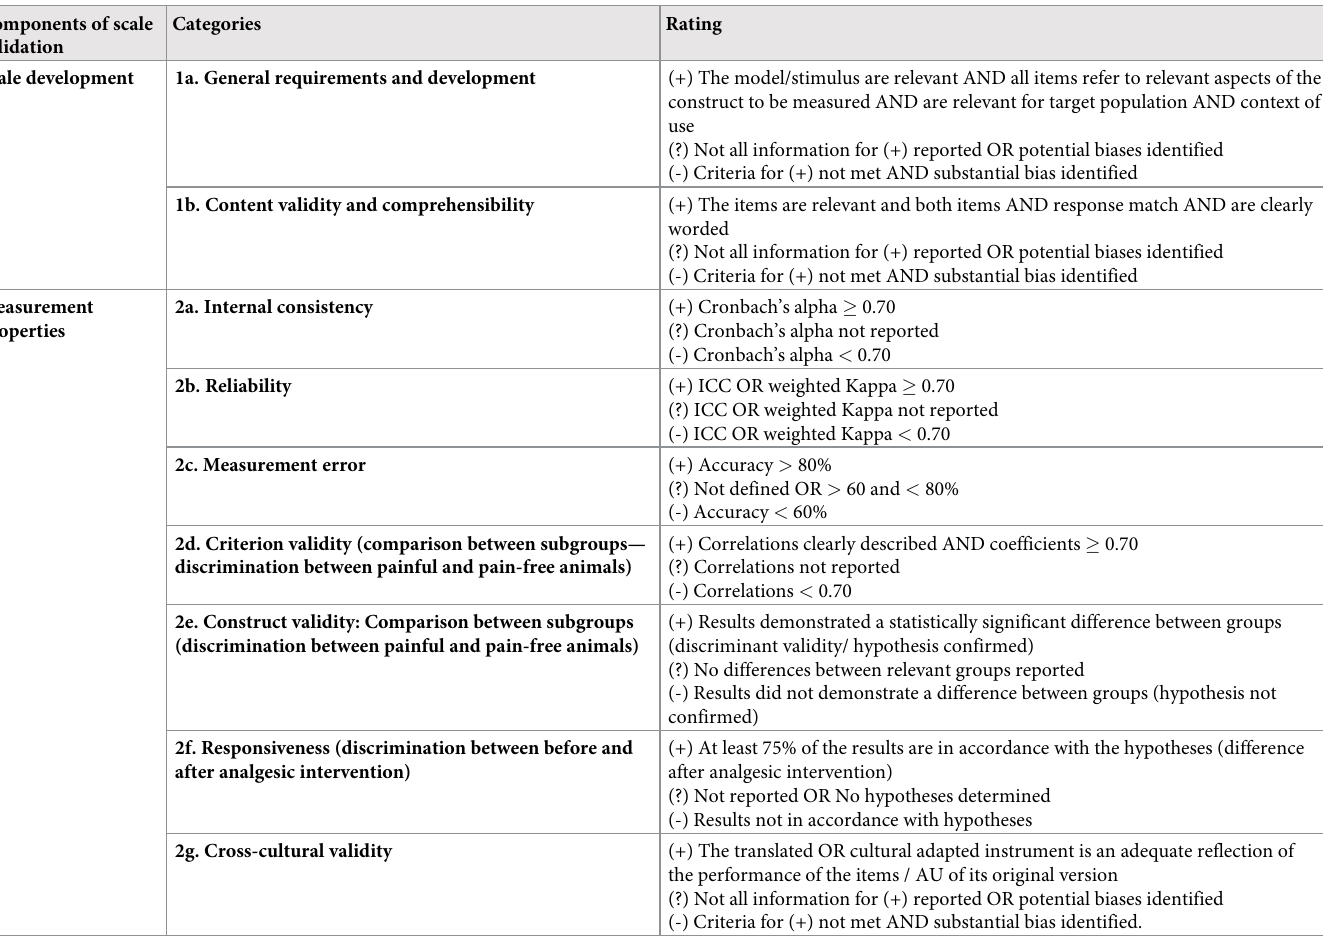
Table 2. Criteria used for rating the quality of the findings (Part B). Adapted from the Consensus-based Standards for the Selection of Health Measurement Instru- ments (COSMIN) [38, 41, 42].